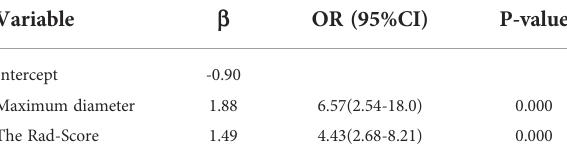
TABLE 4 Variables and coef fi cients of the radiomics nomogram by multivariate logistic regression analysis. Variable b